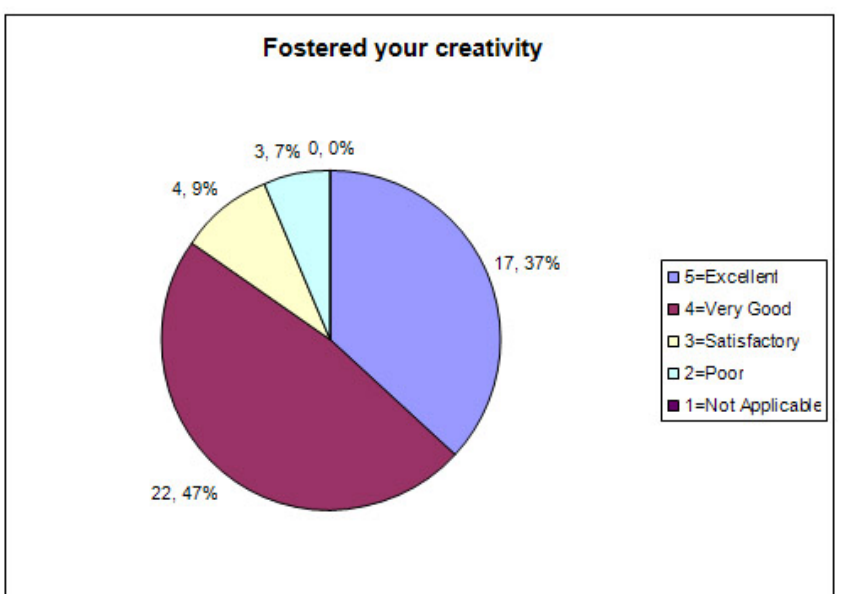
Figure 8. Mobile learning outcomes